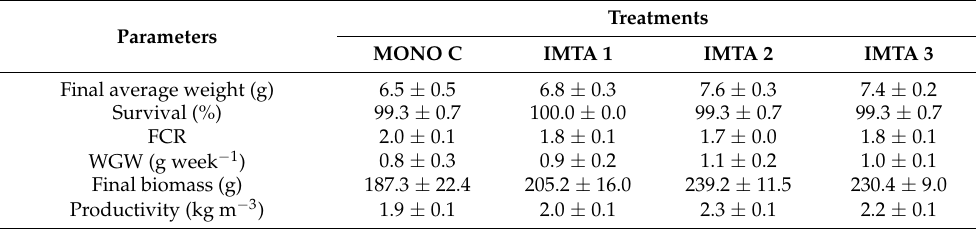
Table 7. The performance of shrimp L. vannamei (mean ± standard deviation) in treatments of MONO C (with no Ulva) in the IMTA 1 (with 1 g Ulva L − 1 ), IMTA 2 (2 g Ulva L − 1 ), and IMTA 3 (3 g Ulva L − 1 ) treatment groups during the 35 days of